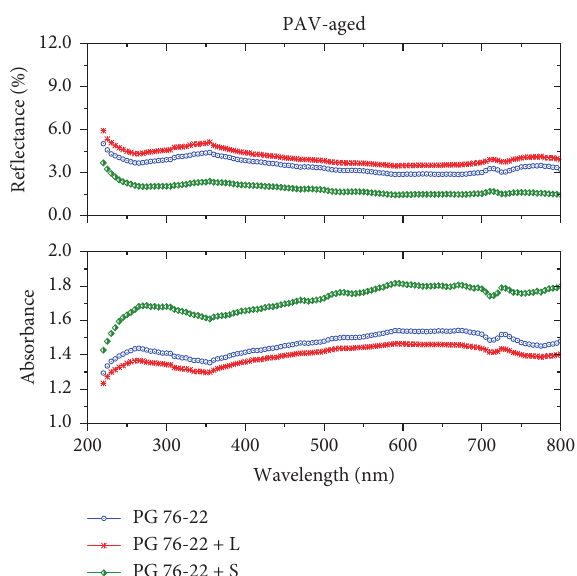
Figure 7: Reflectivity and absorbance of aged warm PMA